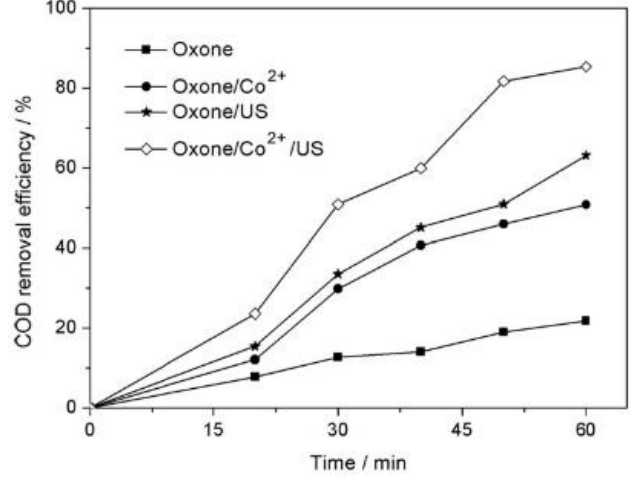
Figure 5. Effect of different treatment methods at room temperature and near-neutral pH in terms of the COD removal efficiency. Experimental conditions: [AMX] = 0.095 mmol/L, [Oxone ® ] = 5 mmol/L [Co 2+ ] = 0.025 mmol/L, T = 24 ◦ C, US = 20 KHz, 200 W. Reprinted with permission from [42].